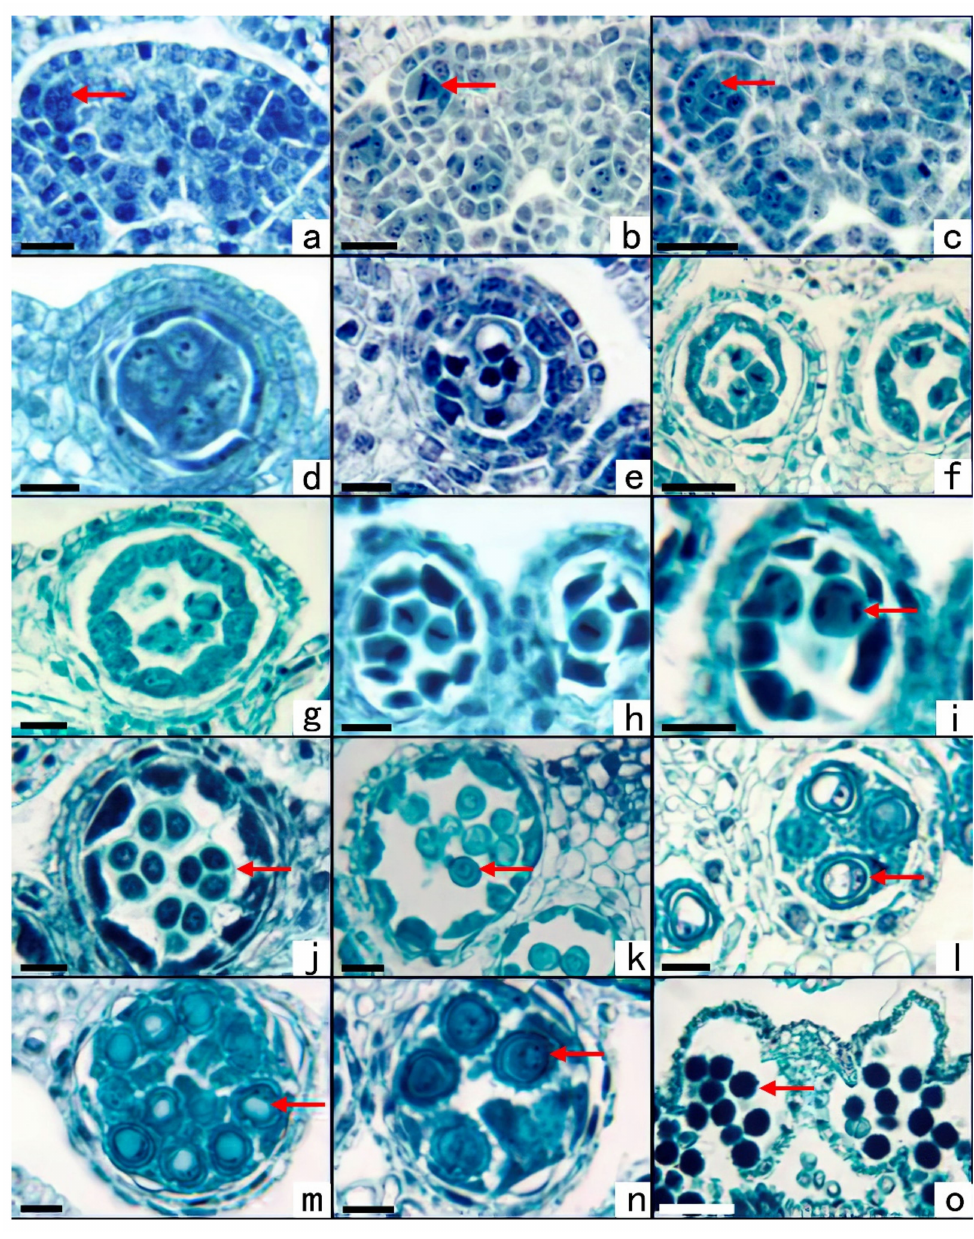
Figure 3. Microsporogenesis and male gametophyte development of S. canadensis (population number: CN04). Section stained with hematoxylin-Fast Green FCF. ( a ). Archesporial cell. ( b ) Archesporial cell in the metaphase of periclinal division. ( c ) Primary parietal cells and primary sporogenous cells. ( d ) Microsporocytes and four-layer walls. ( e ) Prophase I. ( f ) Metaphase I. ( g ) Anaphase I. ( h ) Metaphase II, wherein the tapetum begin to dissolve. ( i ) Anaphase II. ( j ) Tetrahedral tetrad. ( k ) Early one-nucleate microspore, nucleus in the middle of the cell. ( l ) One-nucleate side- stage microspore, and the periplasmodium flows into the anther chamber. ( m ) 2-celled pollen. ( n ) 3-celled pollen. ( o ) Mature pollen escapes from the pollen sac. Scale bars: a–c = 25 µ m, d–e = 12.5 µ m, f = 25 µ m, g–n = 12.5 µ m, o = 50 µ